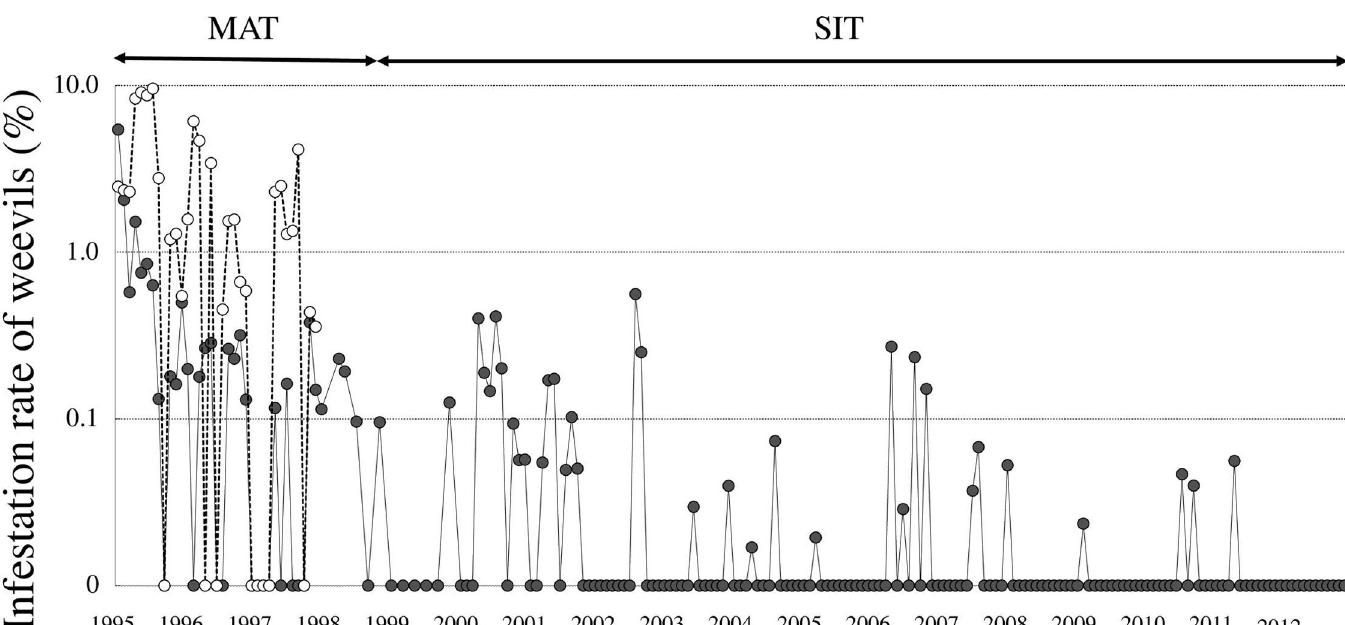
Fig 5. Infestation rate of weevils C . formicarius on wild hosts in Kume Island. Black circles indicate the % infection in MAT and SIT application areas and white circles indicate % infection in the non-MAT application